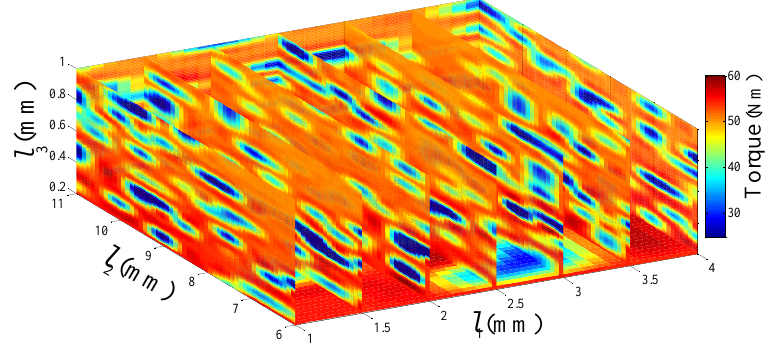
Figure 9. The slice contours of the output torque versus geometrical parameters.